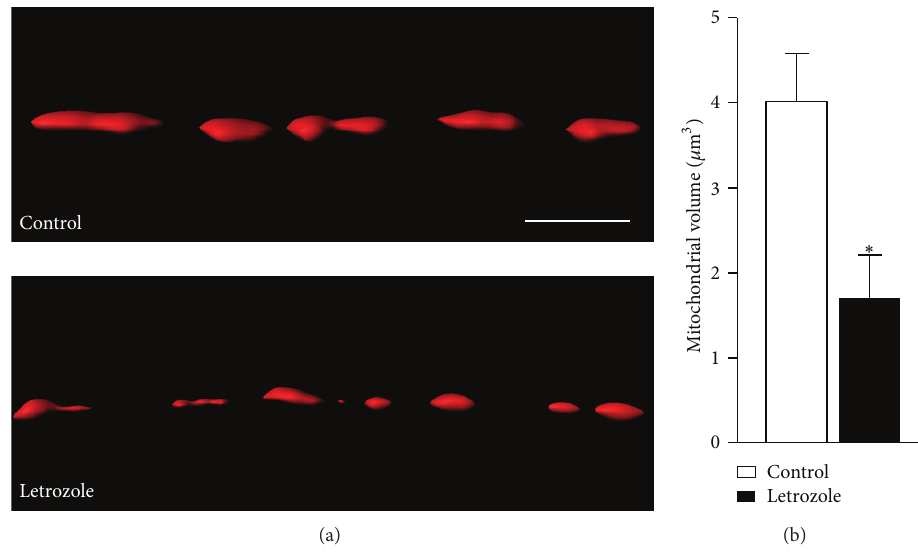
Figure 1: Mitochondrial impairments following 𝐴𝛽 1 and letrozole treatment. (a) Representative 3D reconstructions of MitoTracker – 42 Deep Red-positive mitochondria from hippocampal dendritic segments treated with letrozole (1 𝜇 M) for 72 hours. Scale bar 5 𝜇 m. (b) Quantificationsofmitochondrialvolumes.Significantdifferencesinmitochondrialvolumerelativetocontrol( 4.03 ± 0.56 𝜇 m 3 )wereobserved for letrozole ( 1.72 ± 0.49 𝜇 m 3 , 𝑃 = 0.015 ) and indicated by an asterix ( ∗